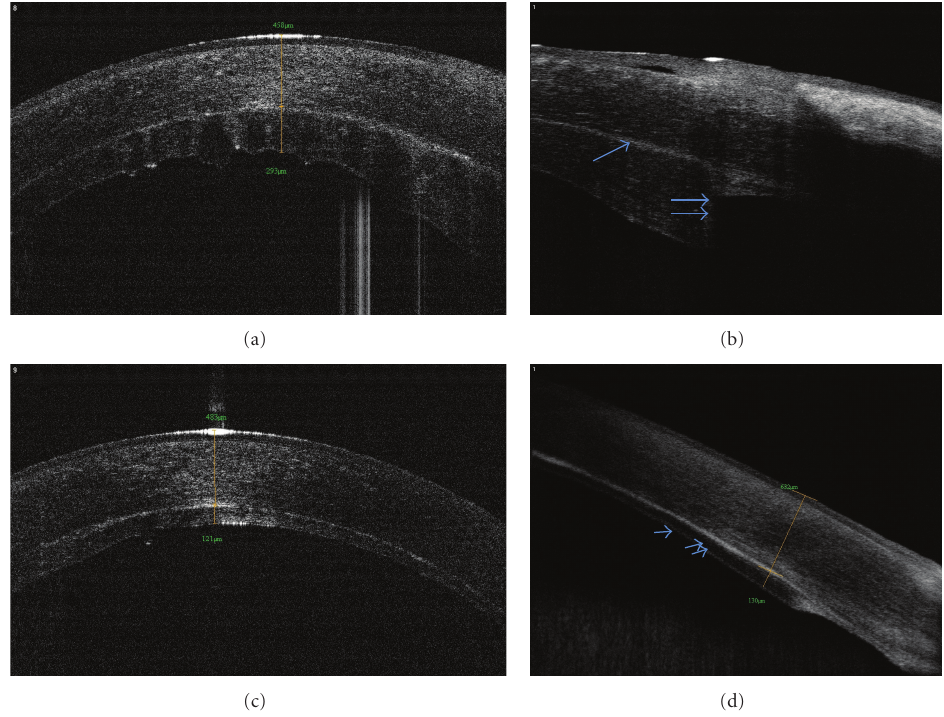
Figure 4: Patient who underwent DSEK in both eyes. First surgery was performed in the right eye, and a regraft (a) was needed due to endothelial failure two months later. (b) Note the graft edge irregularity (single arrow = graft-host interface; double arrow = donor edge). The left eye had an uneventful surgery (c), with optimal apposition (d) of the donor disc (single arrow = donor endothelium; double arrow = donor